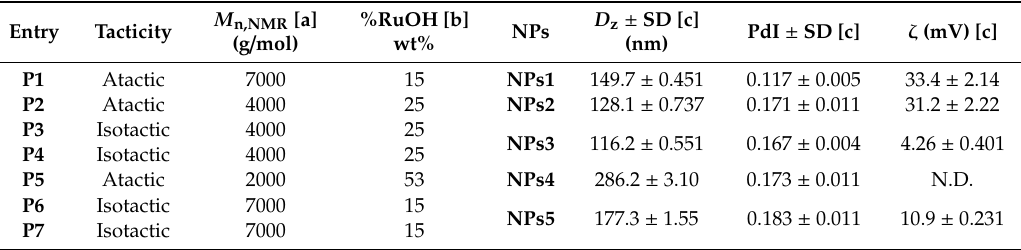
Table 1. Macromolecular and colloidal characterizations of Ru-PLA nanoconjugates.